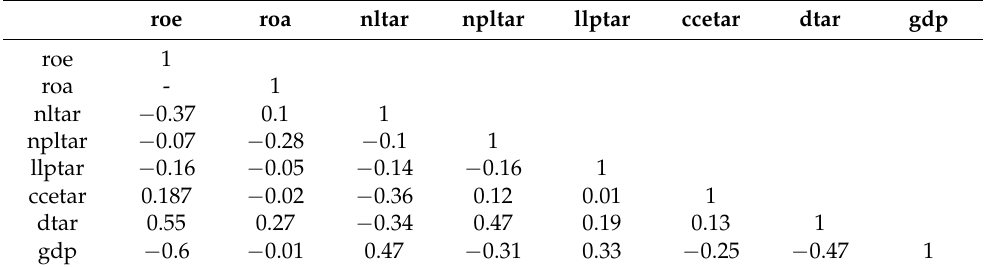
Table 3. Correlation matrix.